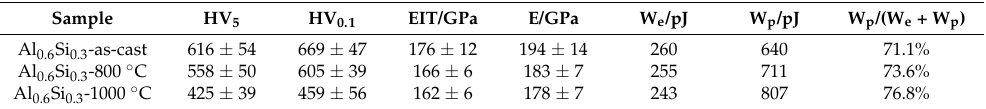
Table 3. Properties of Al 0.6 Si 0.3 high-entropy alloys.